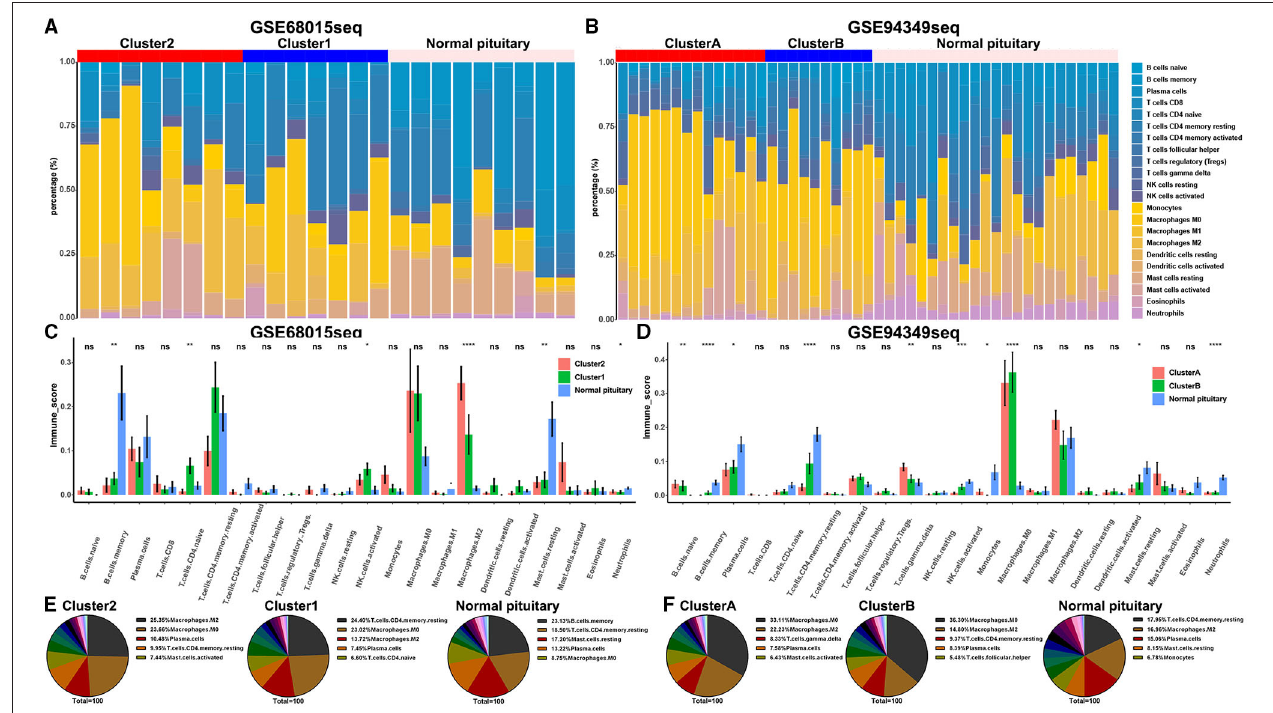
FIGURE 5 | Proportion of TICs in the IG and IR subtypes of ACPs. (A,B) Barplot showing the proportion of 21 kinds of TICs in ACPs and normal pituitary in the GSE68015 and GSE94349 databases. Column names of the plot were sample ID. (C,D) The bar chart showed the ratio differentiation of 21 kinds of immune cells among cluster 1/2, cluster A/B and normal pituitary groups. (E,F) Pie charts showed the distribution of the immune cells among cluster 1/2, cluster A/B and normal pituitary groups. *p < 0.05, **p < 0.01, ***p < 0.001, ****p < 0.0001.